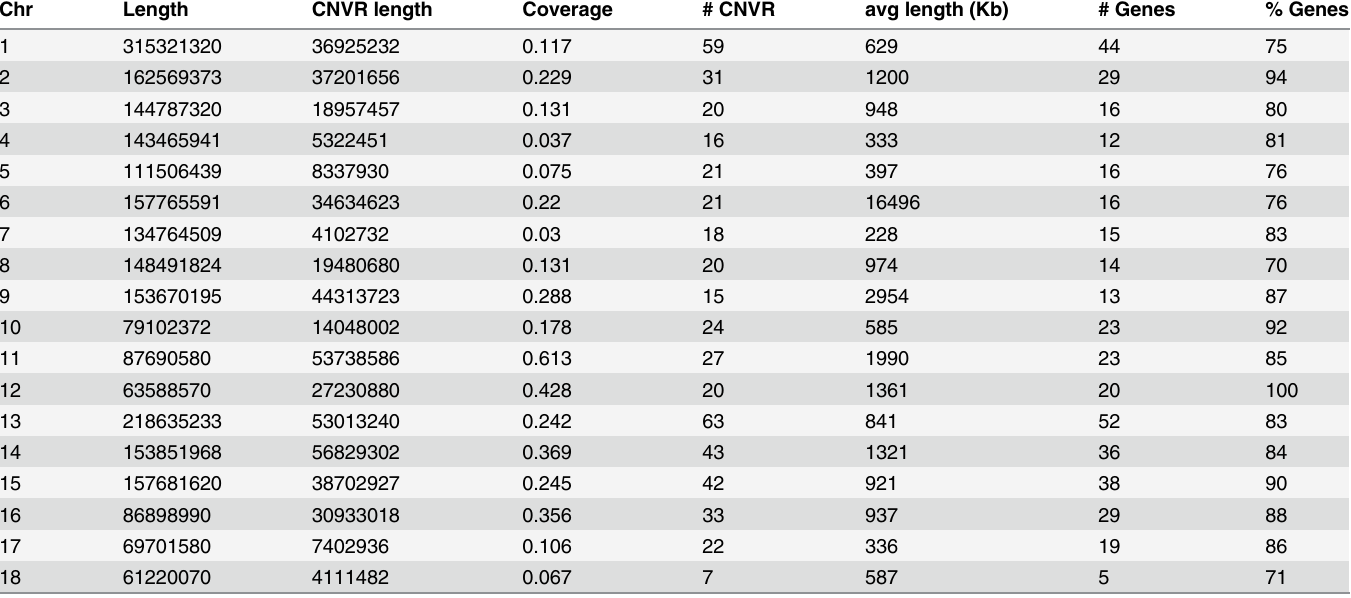
Table 1. Summary of the CNVR content of each autosome and the frequency of overlap with